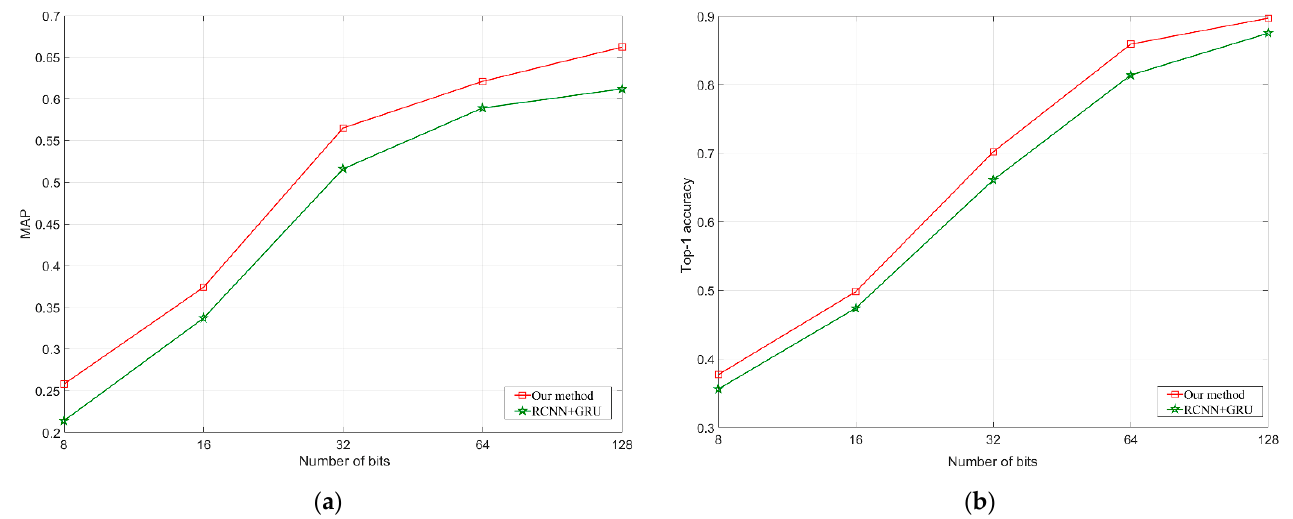
Figure 5. The accuracy comparison between our method and RCNN method using spatio-temporal features: ( a ) MAP comparison; ( b ) Top-1 accuracy comparison.